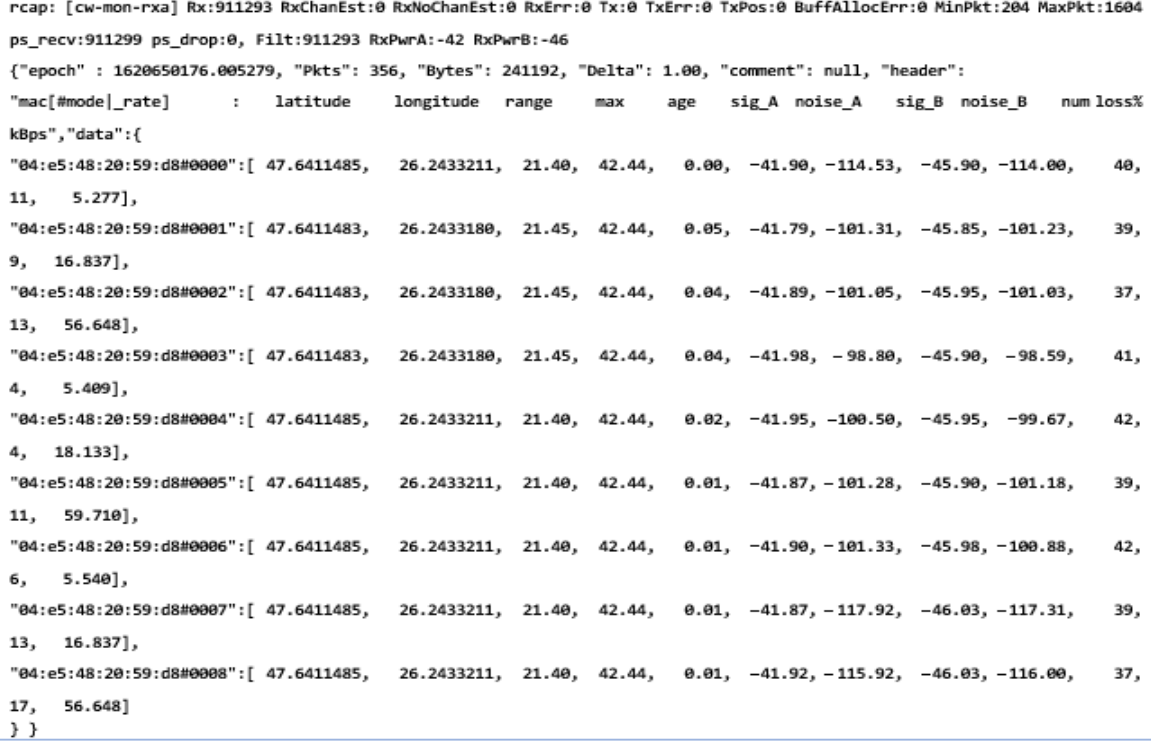
Figure 21. Initialization of the communication process.